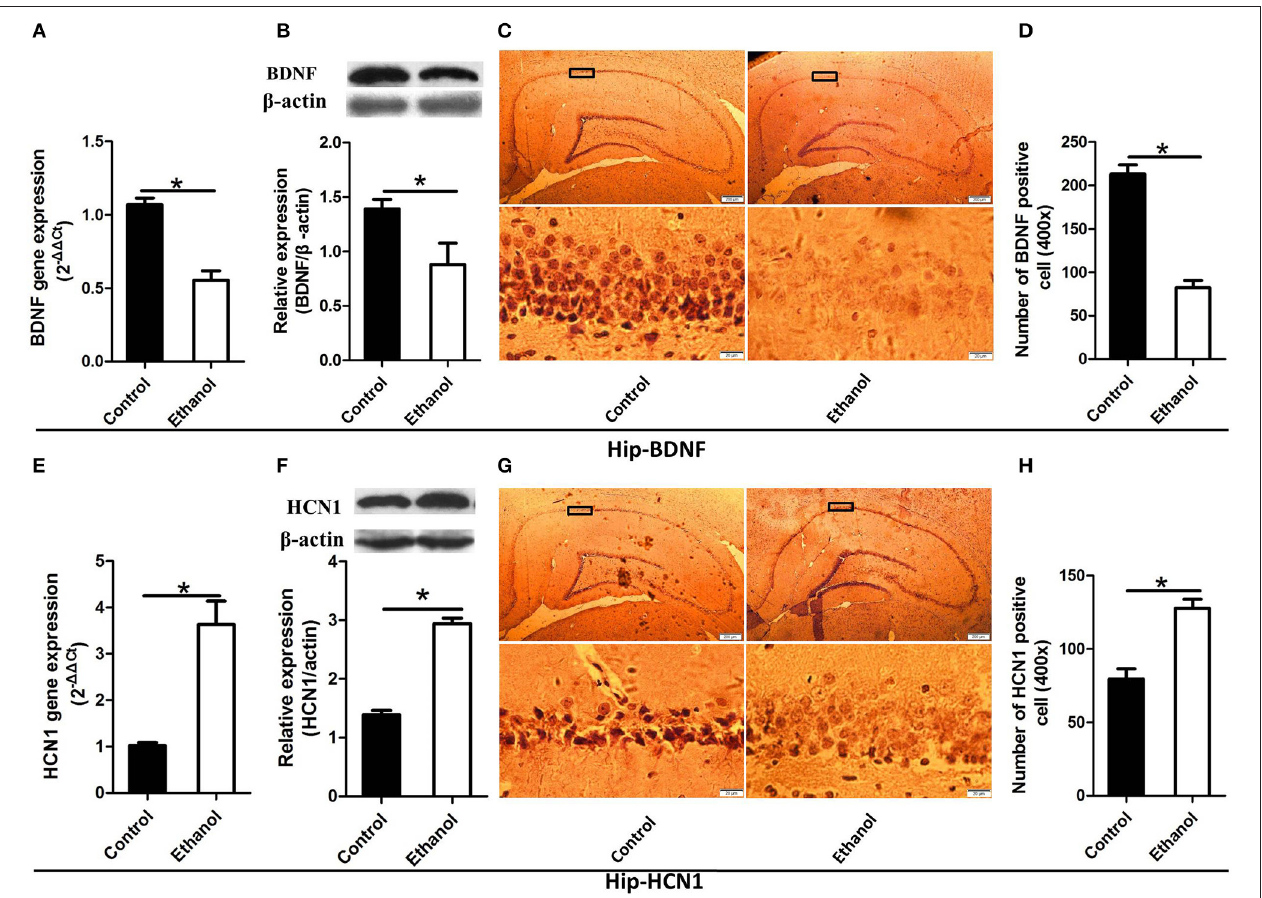
FIGURE 4 | Effects of the ethanol withdrawal procedure on the hyperpolarization-activated cyclic nucleotide-gated cation channel (HCN1) and brain-derived neurotrophic factor (BDNF) protein or gene level changes in the hippocampus (Hip). (A) The expression of BDNF BDNF mRNA in the Hip. (B) The expression of BDNF-positive cells in the Hip. (C) Expression of BDNF positive cells in the Hip. (D) The number of BDNF-positive cells in the Hip. (E) The expression of HCN1 mRNA in the Hip. (F) The expression of HCN1-positive cells in the Hip. (G) Expression of HCN1 positive cells in Hip. (H) The number of HCN1-positive cells in the Hip. The BDNF- and HCN1-positive cells in the Hip are represented by photomicrographs (400 × ). Data are mean ± standard error. * P < 0.05 was